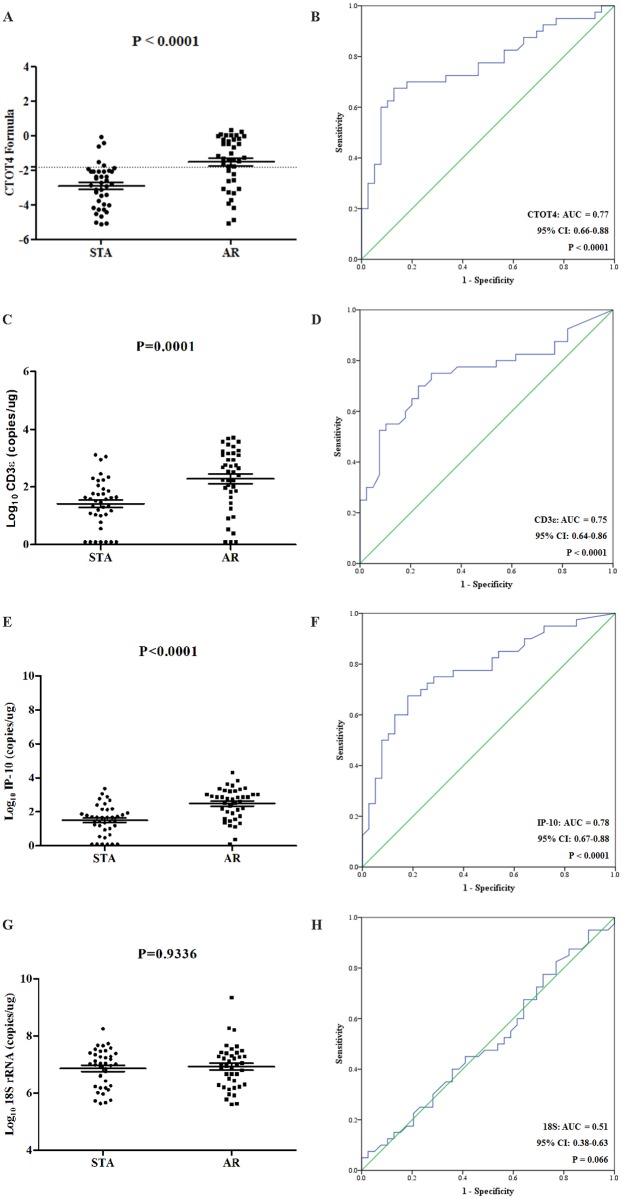
The mRNA levels of the CTOT4 formula and the mRNAs in ddPCR.(A) The CTOT4 formula, (C) CD3ε, (E) IP-10, and (G) 18S rRNA represented the absolute mRNA levels between two groups analyzed by ddPCR, respectively. (B, D, F, H) The results corresponding ROC curve analyses for the CTOT4 formula and three genes, respectively.